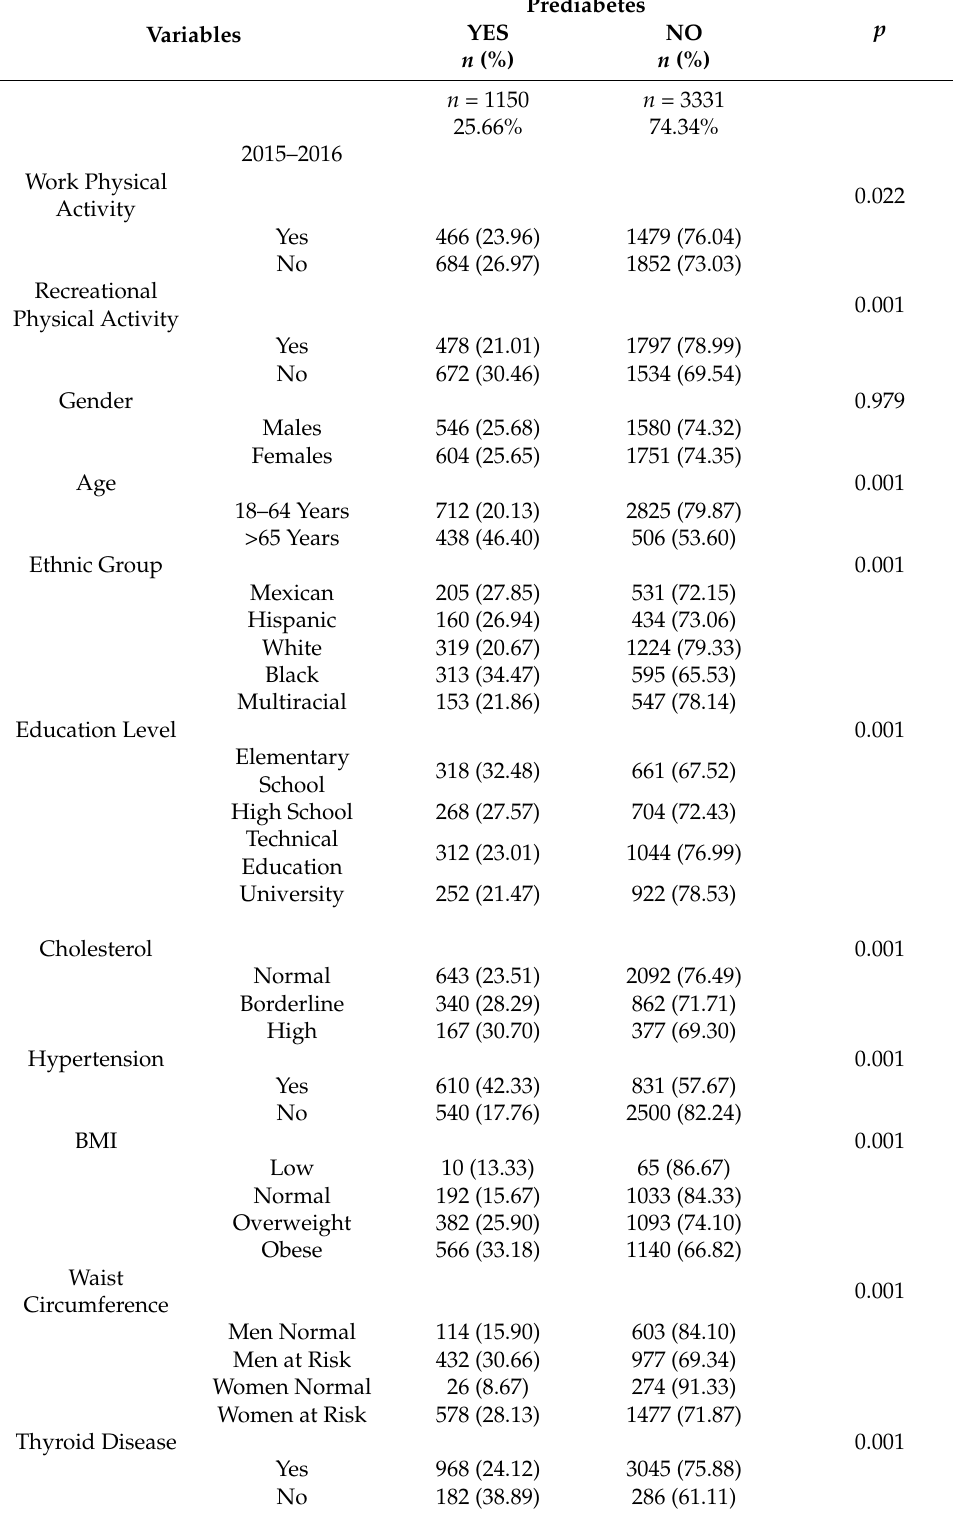
Table 3. Association between prediabetes and work/recreational physical activity in U.S. adults from the NHANES